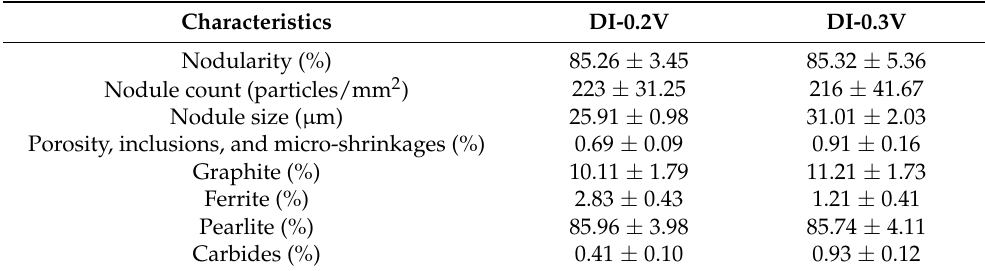
Table 3. Graphite features and volume fraction of phases formed for camshaft alloyed with 0.2 and